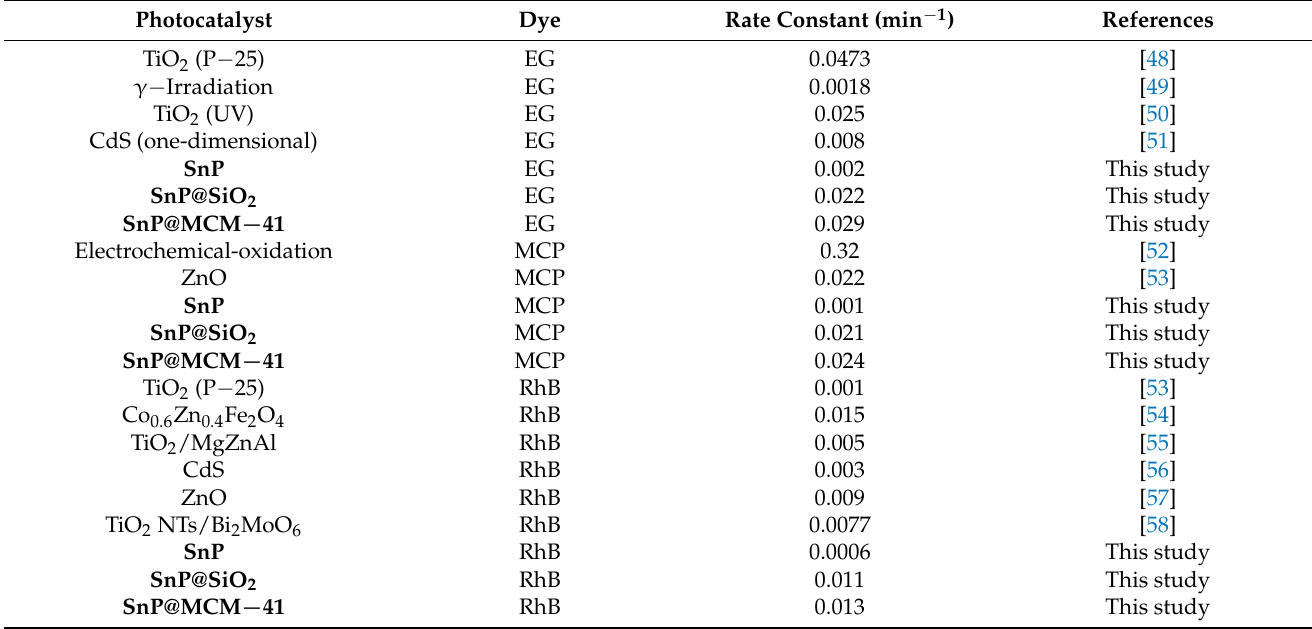
Table 1. Performances of degradation for EG, MCP, and RhB by various photocatalysts.